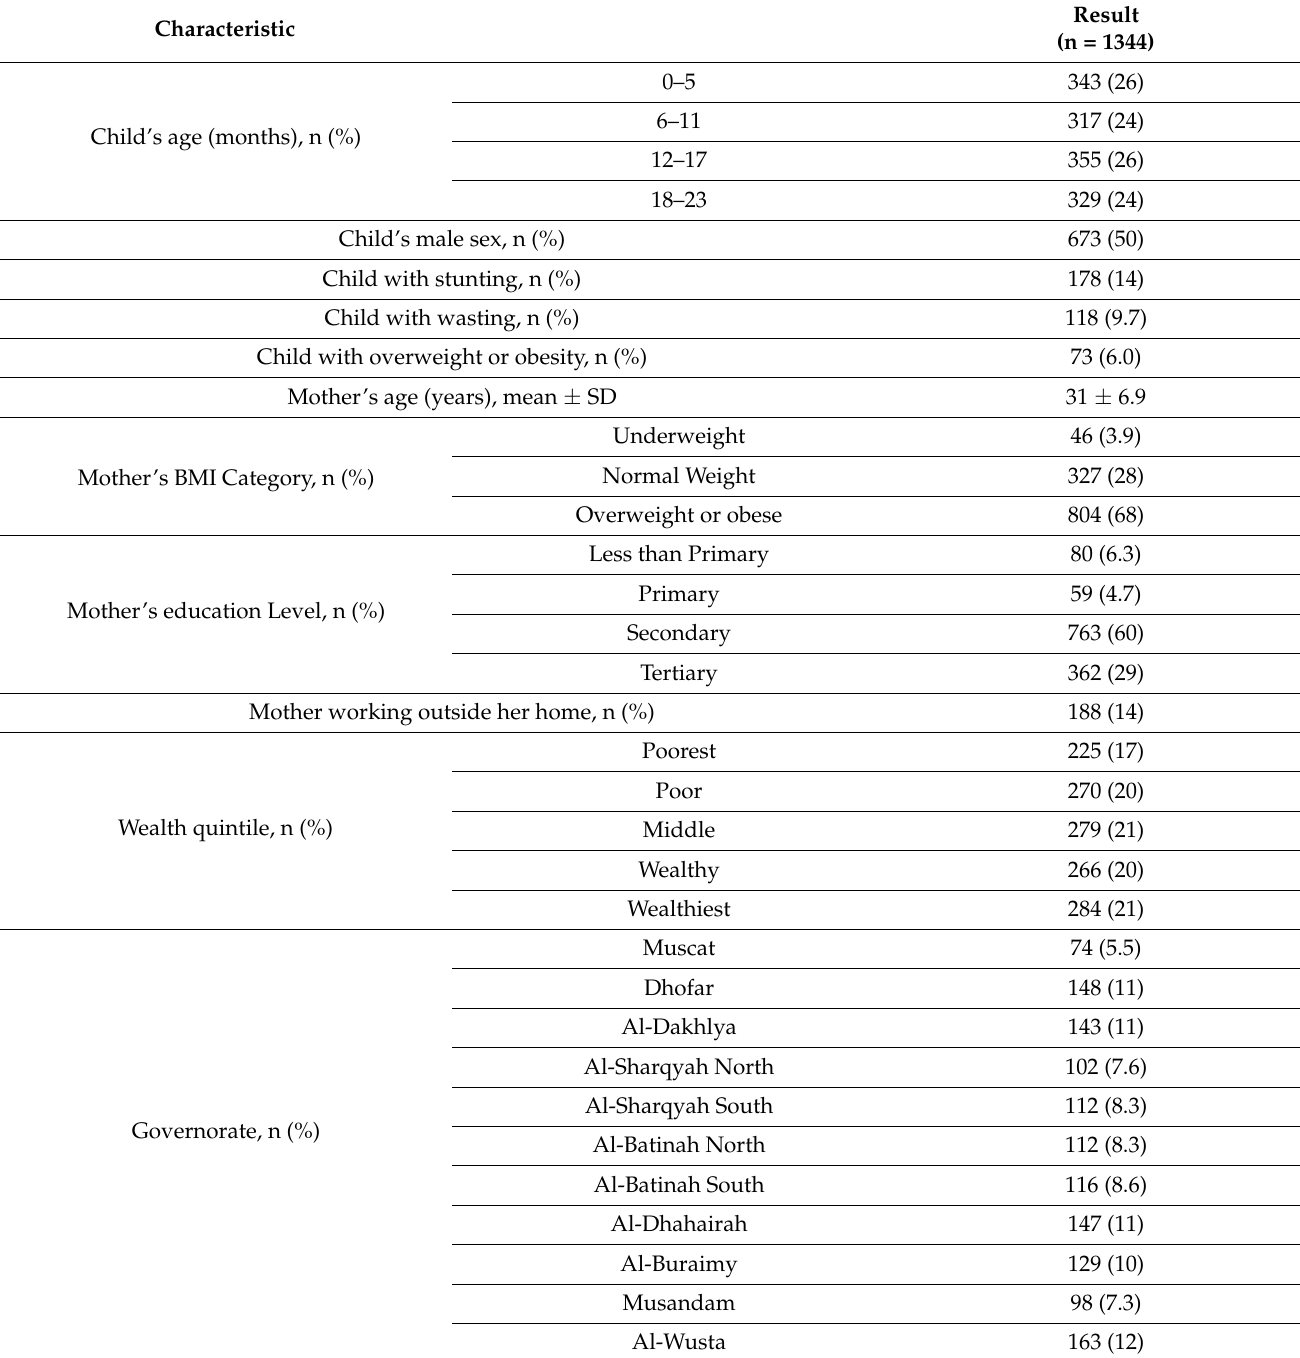
Table 1. Mothers and children